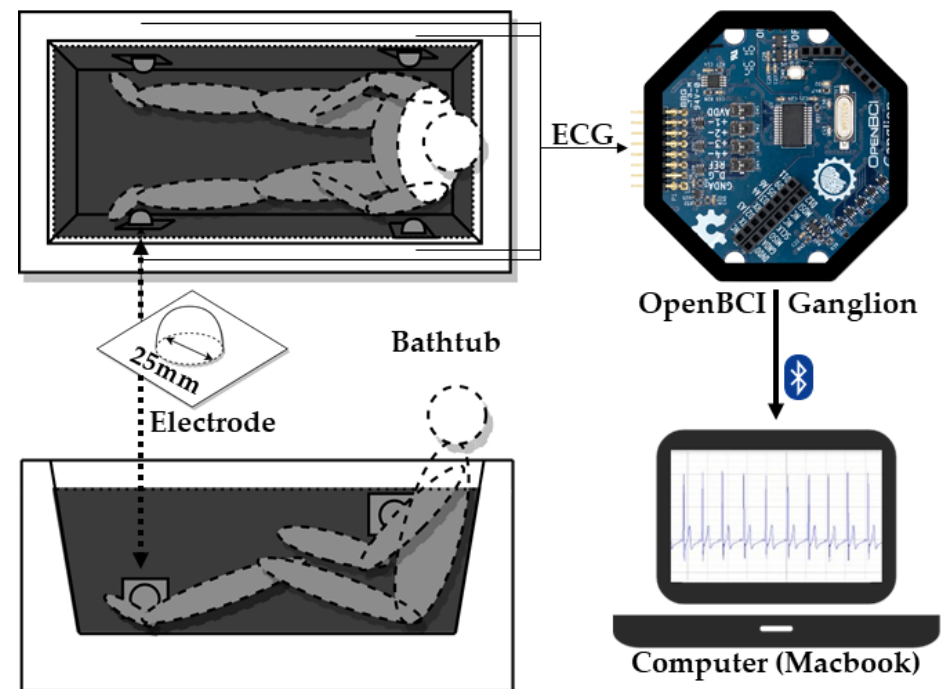
Figure 2. Scheme of the bathtub ECG monitoring system for BT.